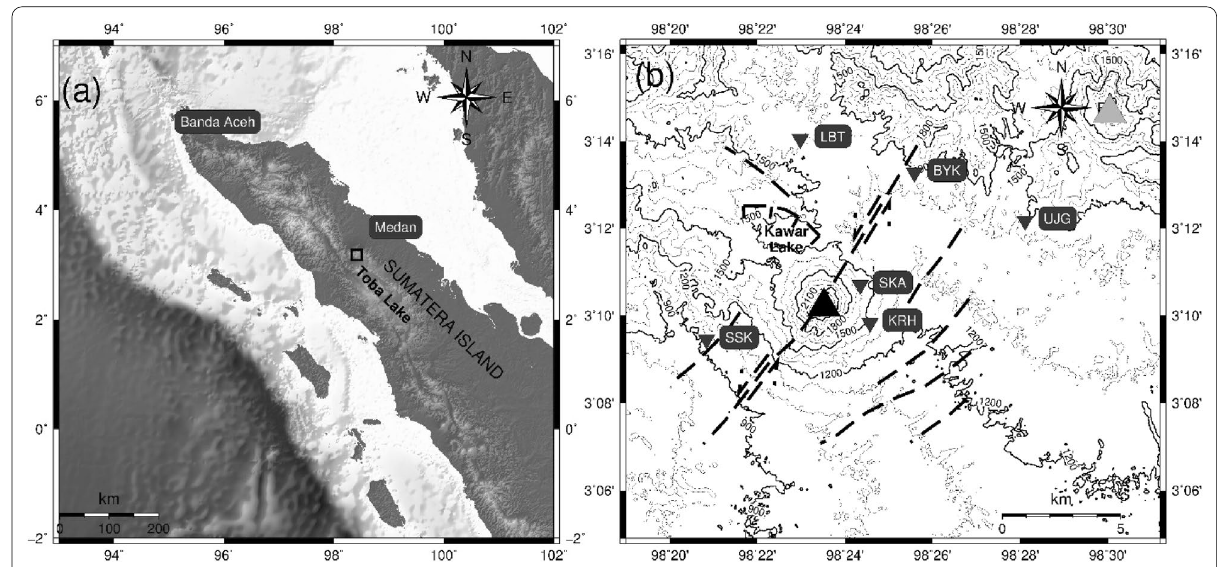
Fig. 1 a The study area (black rectangle) is about 88 km from Medan, the capital city of North Sumatera Province. b The zoom of the black rectangle of (a). The black triangle is the summit of the Sinabung volcano and the grey one is the Sibayak volcano. The inverted triangles are seismic stations. The thick dashed lines are possible fault lines from Prambada et al.